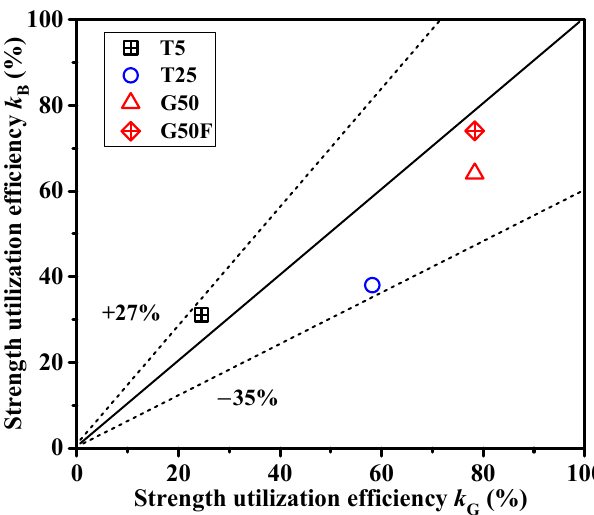
Figure 9. Comparison results of the fiber strength utilization efficiency.